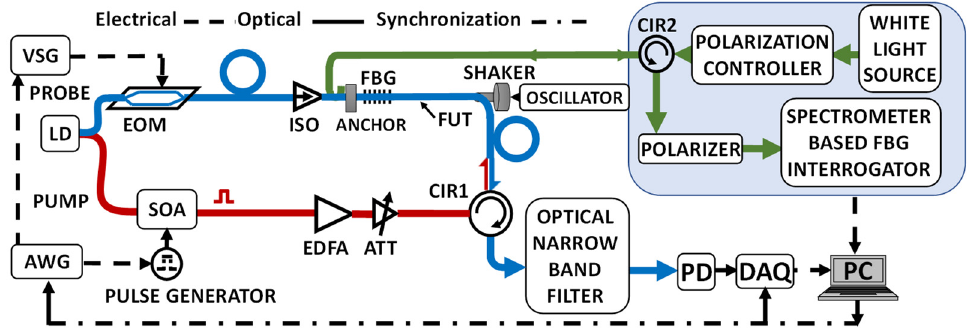
Figure 8. A longitudinally vibrating fiber is interrogated by either an all-polarization-maintaining F-BOTDA setup, producing temporally non-uniform samples, or by a uniformly sampling white- light spectrometer-based interrogator that measures the response of an on-fiber FBG. The λ B of the inscribed FBG is away from the Brillouin scanning region. AWG: Arbitrary Waveform Generator, RF: Radio frequency, SOA: Semiconductor Optical Amplifier/switch, EDFA: Erbium Doped Fiber Amplifier, ISO: Optical isolator, FBG: Fiber Bragg Grating inscribed on the FUT, PD: Photo diode, CIR: Circulator, EOM: Electro-Optic Modulator, LD: Narrowband Laser Diode, DAQ: Data Acquisition, VSG: Vector Signal Generator, ATT: Attenuator.